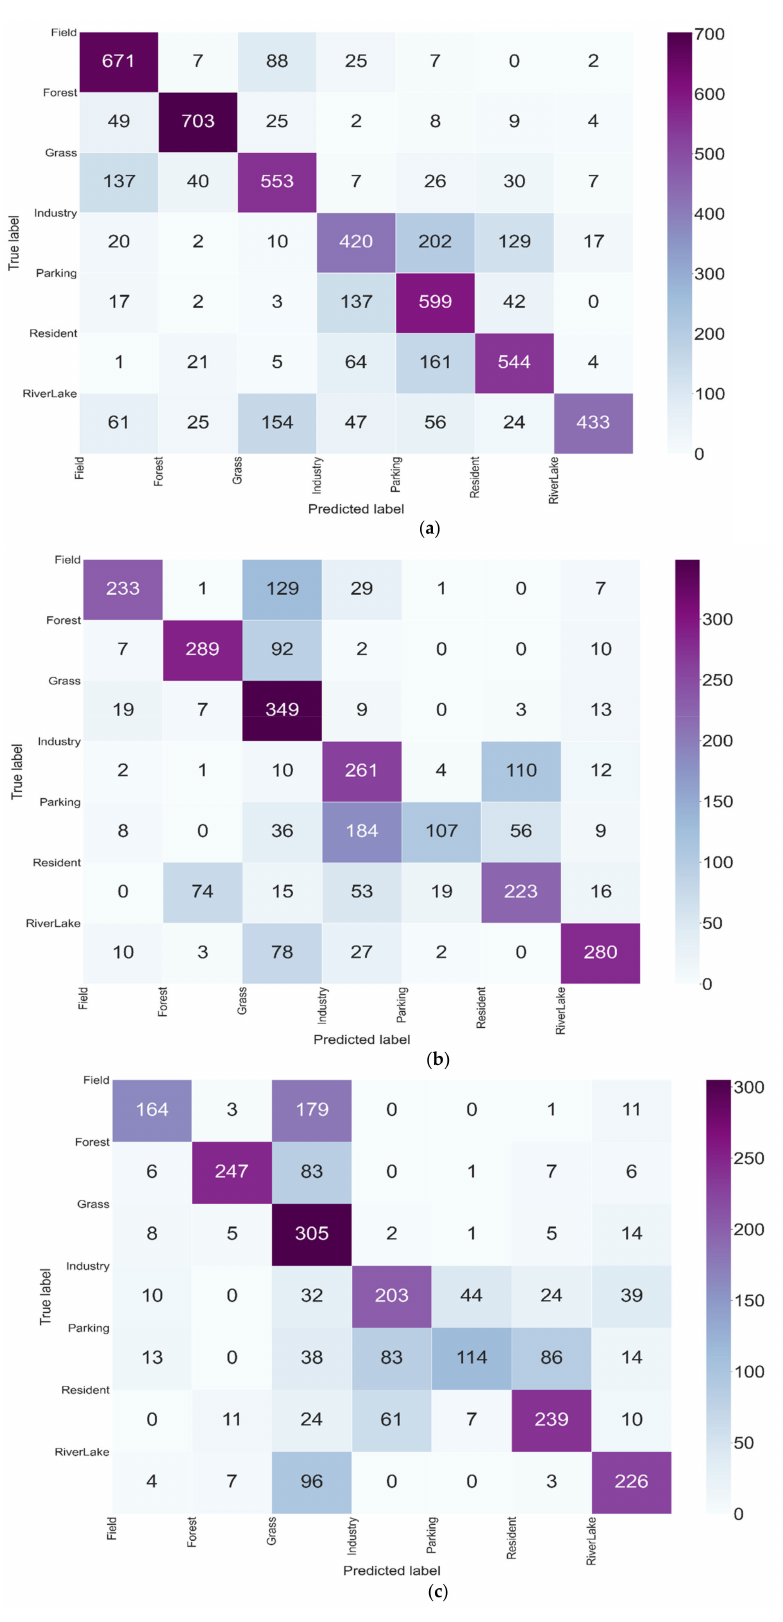
Figure 15. Comparisons of confusion matrices on the three different datasets in RSSCN7 Dataset. ( a ) Datasets with fake samples generated by the improved SinGAN, ( b ) Datasets with true samples used for the training of the improved SinGAN, ( c ) Datasets with random samples selected randomly by the classifier